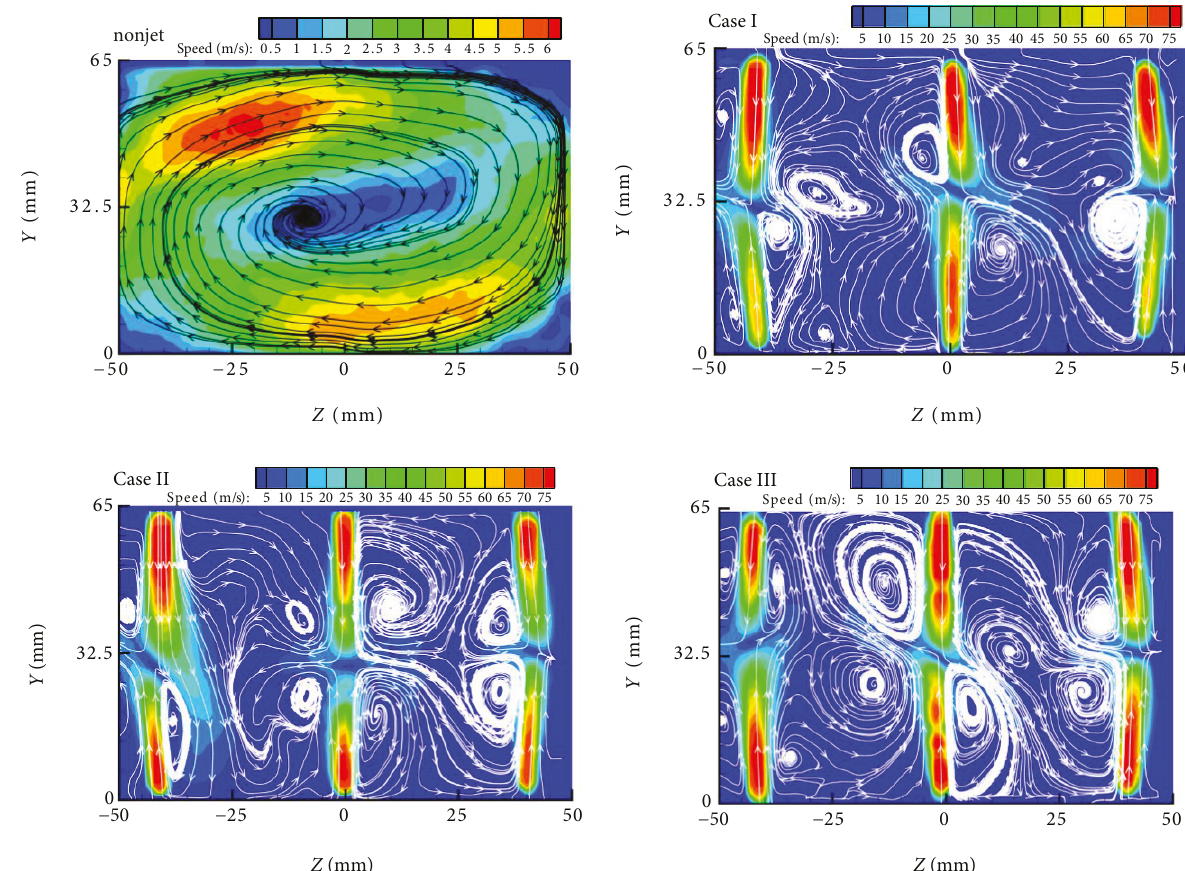
Figure 15: Resulting velocity contours and streamline on the X = 63 5mm